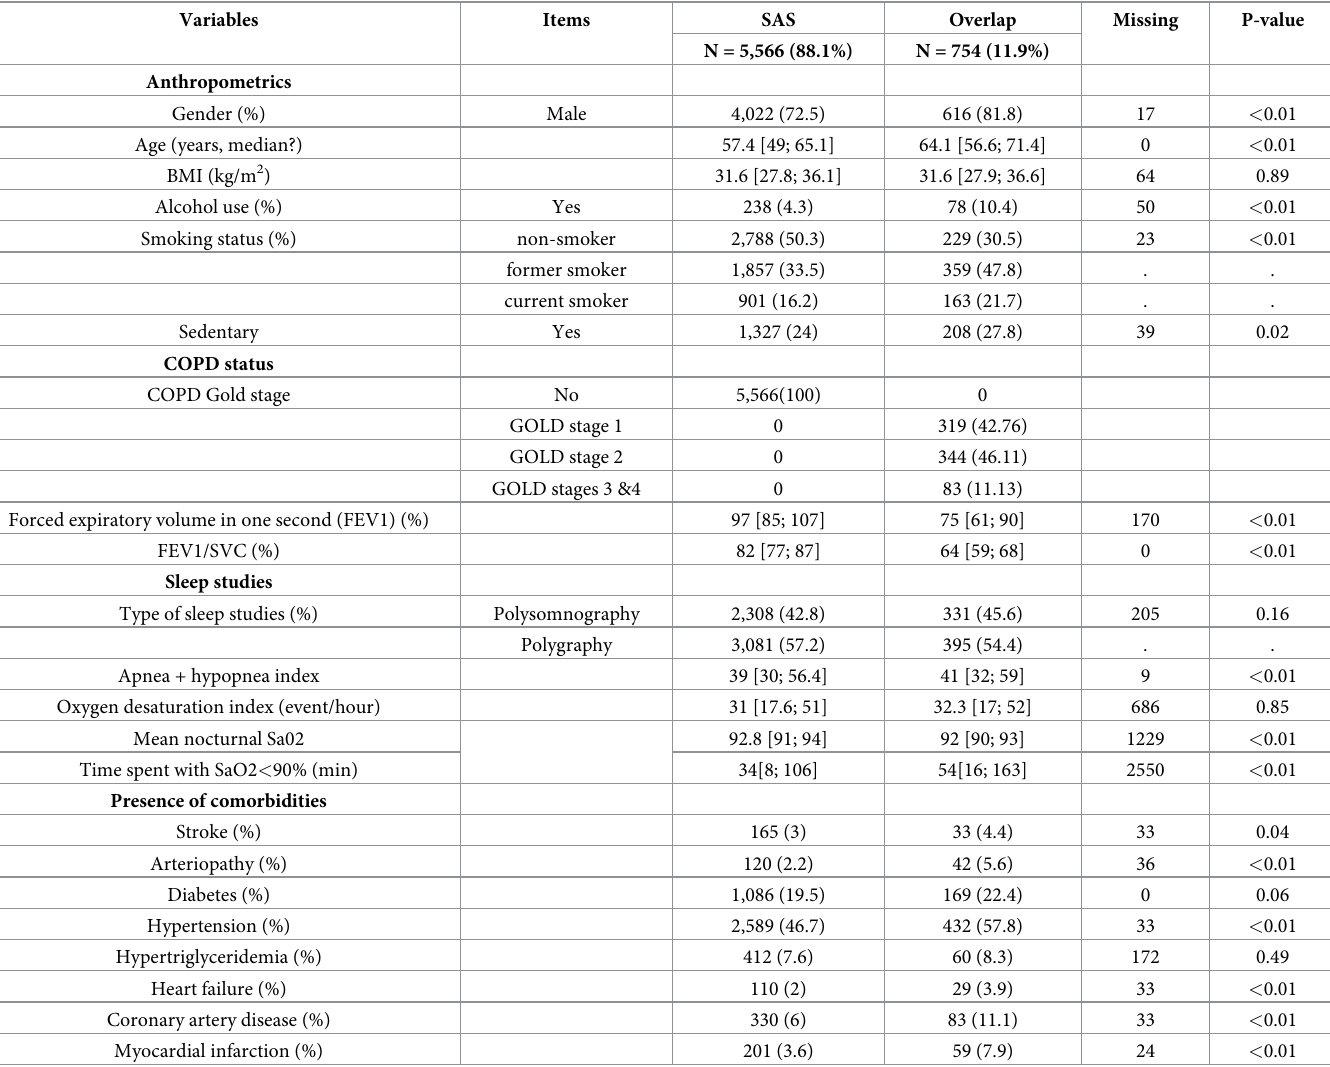
Table 1. Patient demographics, pulmonary function tests, sleep studies and comorbidities at inclusion.